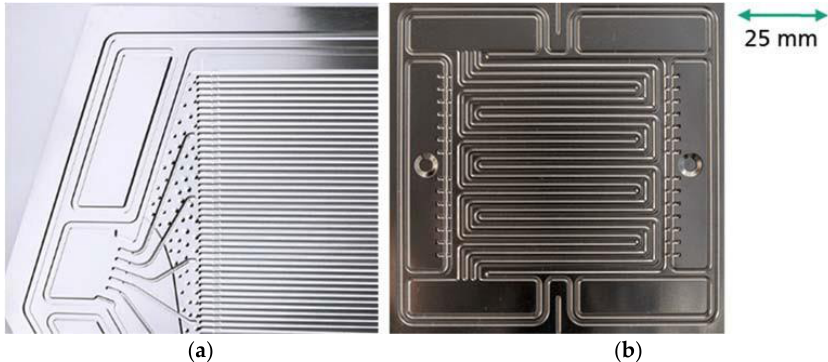
Figure 6. Bipolar plates produced by ( a ) active hydroforming, ( b ) passive hydroforming.